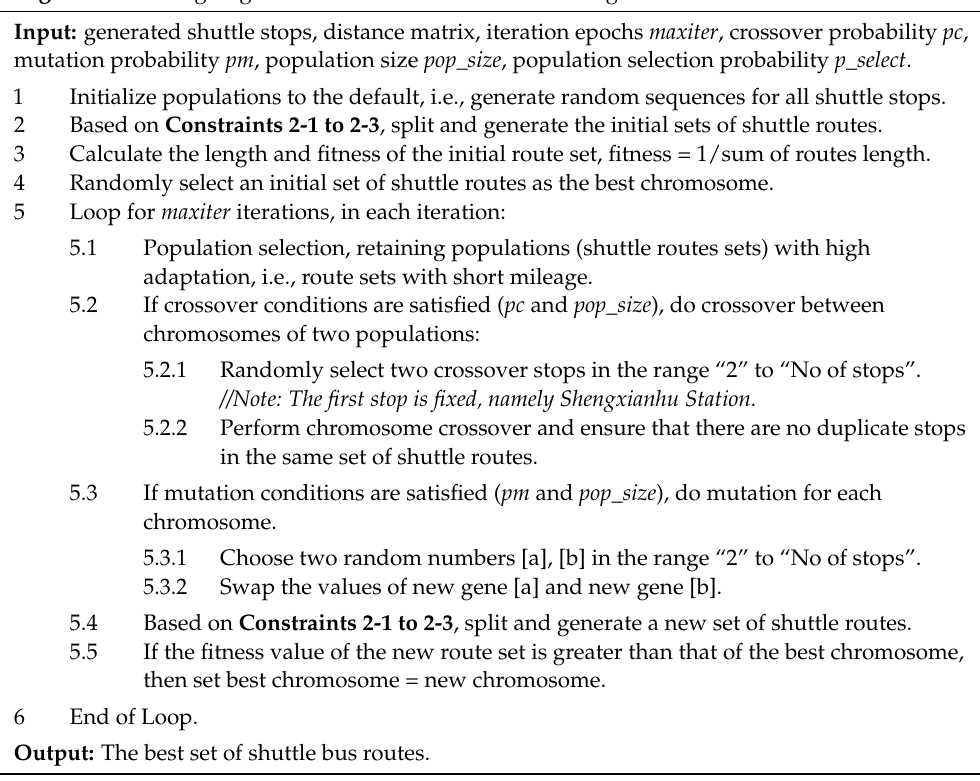
Algorithm 1. Designing Shuttle Bus Routes with Genetic